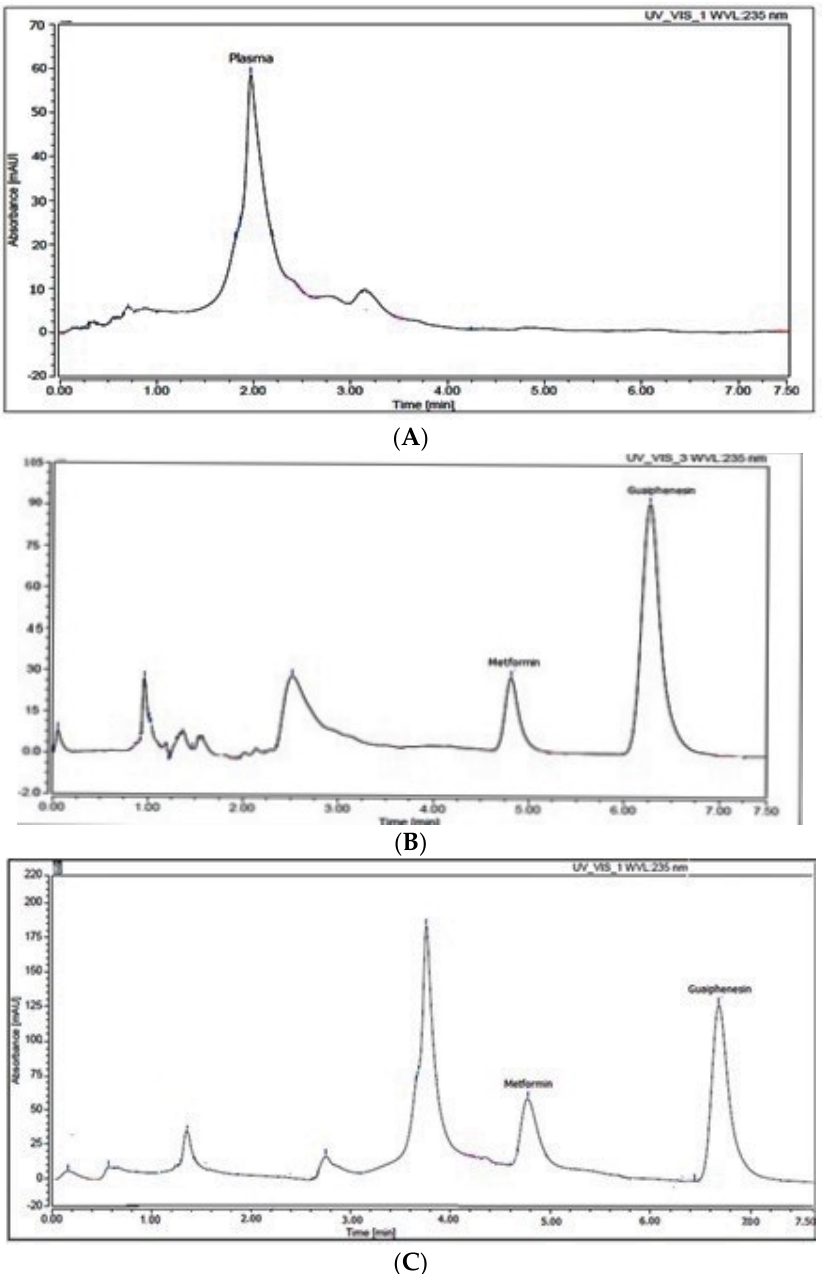
Figure 1. HPLC chromatogram of ( A ): blank plasma, ( B ) plasma spiked with 15 µg mL − 1 metformin and 50 µg mL − 1 guaiphenesin, and ( C ) rat plasma sample after 0.25 h (from group III) spiked with 50 µg mL − 1 guaiphenesin.